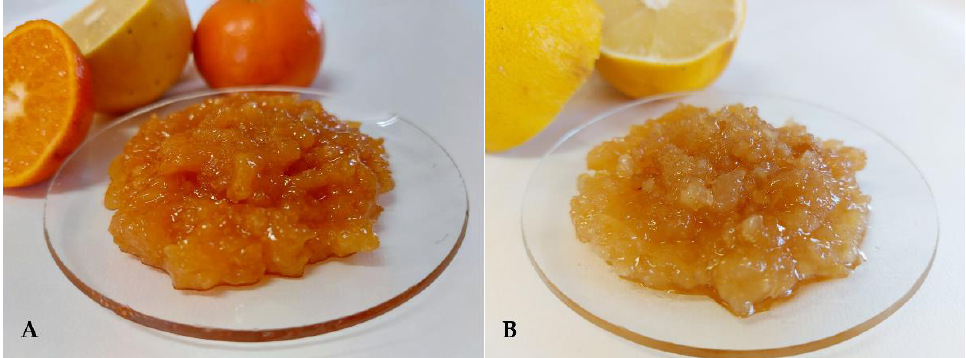
Figure 6. Coctura ® Mixed Citrus ( A ) and Lemon ( B )